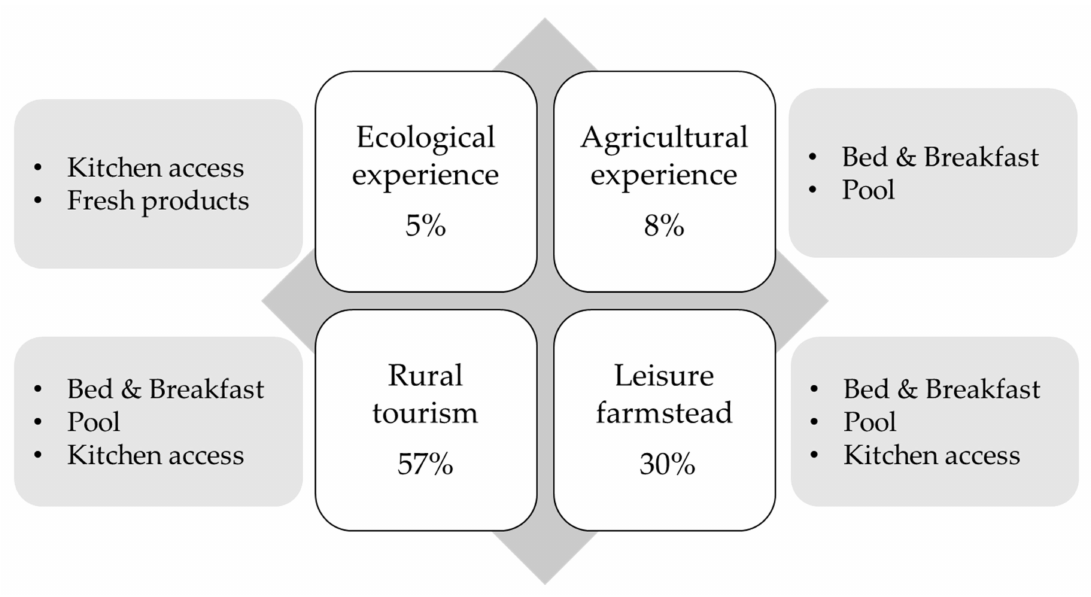
Figure 5. Types of farms and main services/facilities. Source: Own elaboration, based on the authors